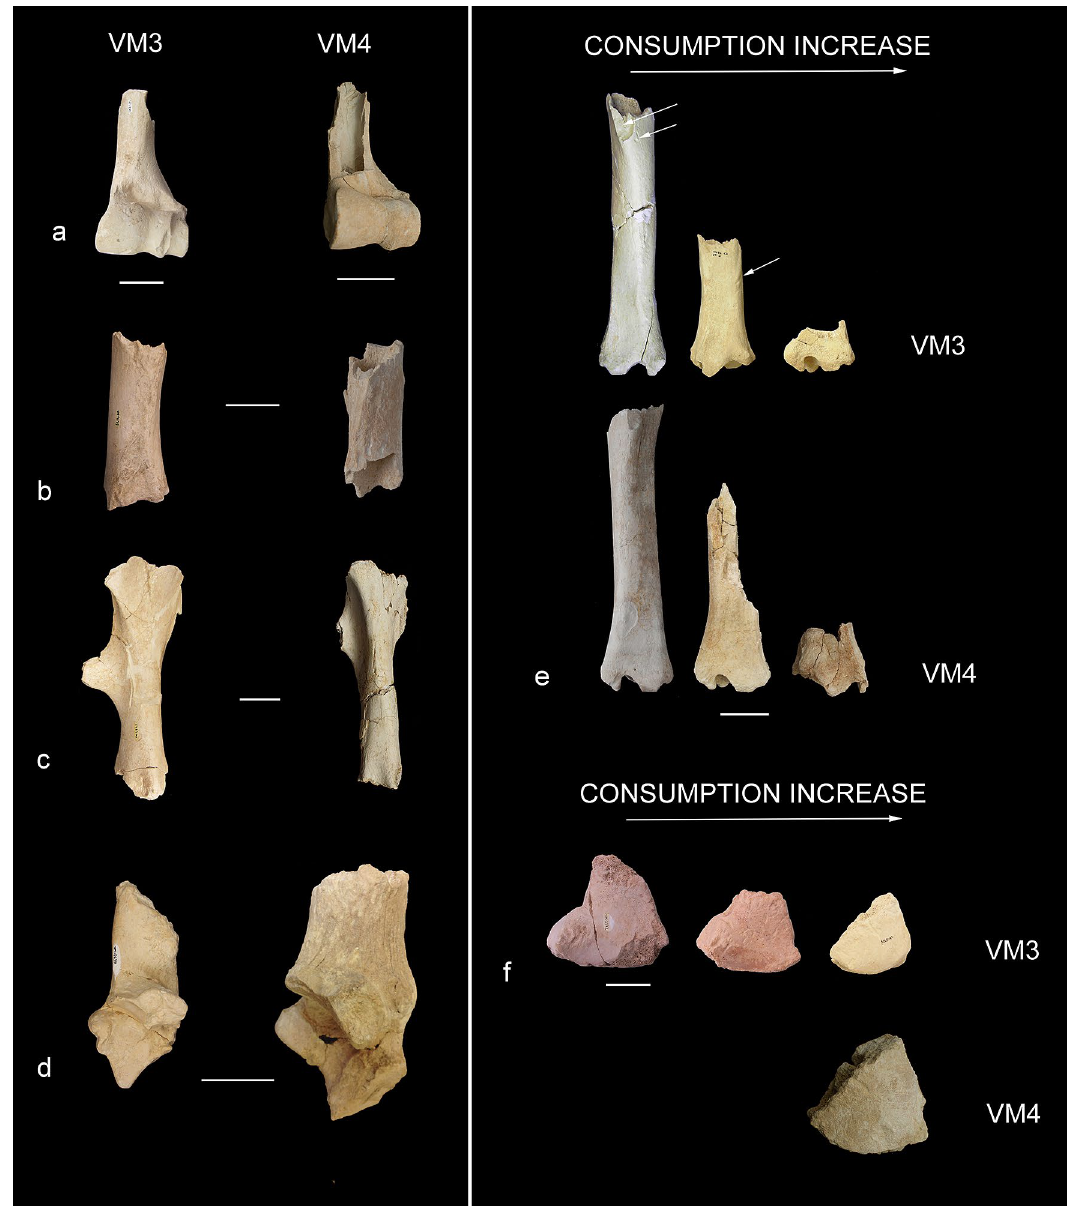
Figure 4. Postcranial remains from quarries VM3 (left) and VM4 (right) of Venta Micena showing similar patterns of bone consumption by the hyaenas 6–10 . ( a ) Distal humeri of Bison sp. (left) and Equus altidens (right). ( b , c ) Femur diaphyseal fragments of large sized herbivores. ( d ) Calcanei of Bovini (left) and Hippopotamus antiquus (right). ( e ) Sequences of consumption of tibiae from large-sized ungulates (upper sequence: VM3, lower sequence: VM4). ( f ) Sequences of consumption of lunate bones of Mammuthus meridionalis (upper sequence: VM3, lower sequence: VM4; the difference of size is because the lunate of VM4 is from an adult individual while those of VM3 are from juveniles). Scale bars represent 5